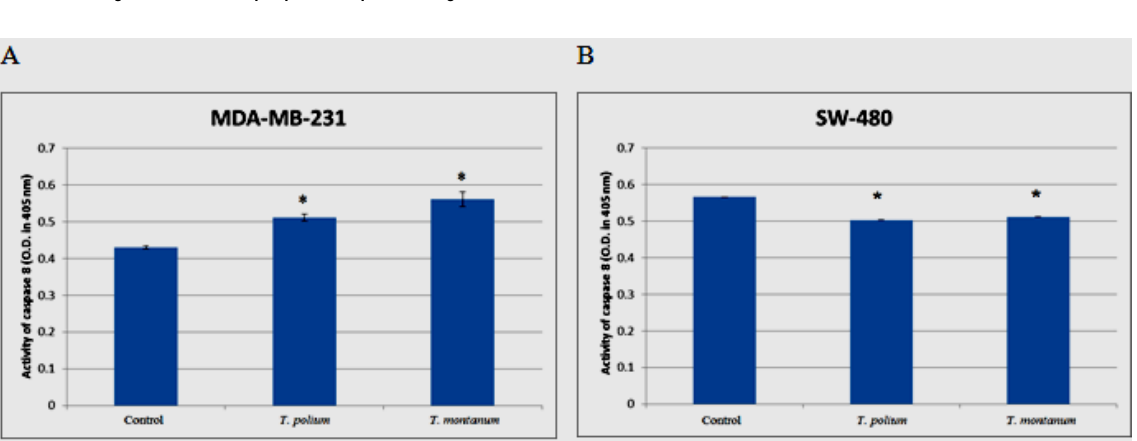
Figure 5. Caspase 8 activity in MDA-MB-231 (A) and SW-480 (B) control cells and cells treated by T. polium and T. montanum extracts. Cells were incubated with treatments for 24 h. Results are expressed as means ± SE for three independent determinations. *P < .05 compared to untreated